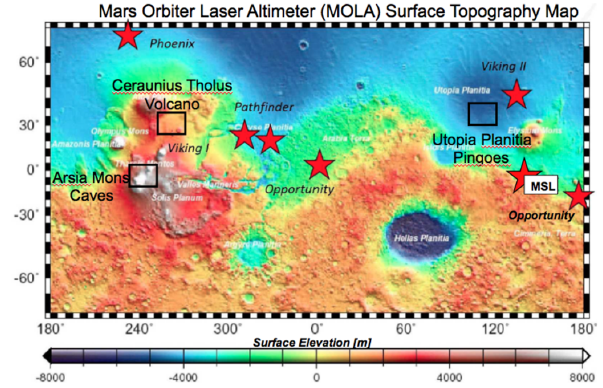
Fig. 7. An elevation map showing some of the geological regions of interest (black rectangles) and locations of past Mars landers (red stars) from the Mars Orbiter Laser Altimeter MOLA (Smith et al.,